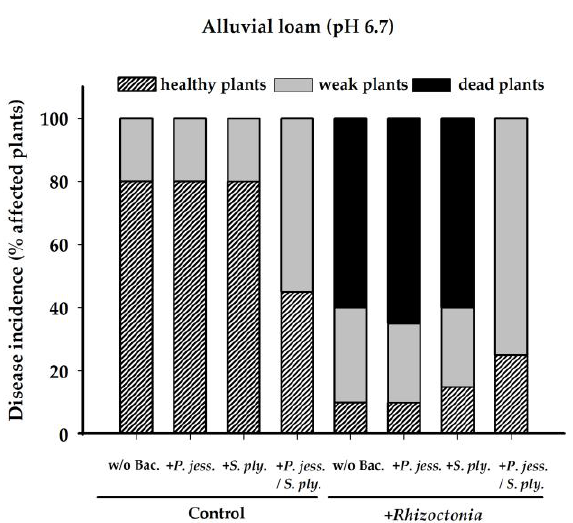
Figure 2. Visual scoring of disease incidence of Lactuca sativa L. cv. Tizian, expressed as percentage of healthy, weak (growth depression and leaf necrosis due to fungal infection), and dead plants. The plants were grown on alluvial loam without bacterial inoculation (w/o Bac.), pre-inoculated with Pseudomonas jessenii RU47 ( +P. jess. ), Serratia plymuthica 3Re-4-18 ( +S. ply. ), a combination of both ( +P. jess/S. ply. ), with and without (Control) subsequent inoculation with Rhizoctonia solani AG1-IB (+ Rhizoctonia ).